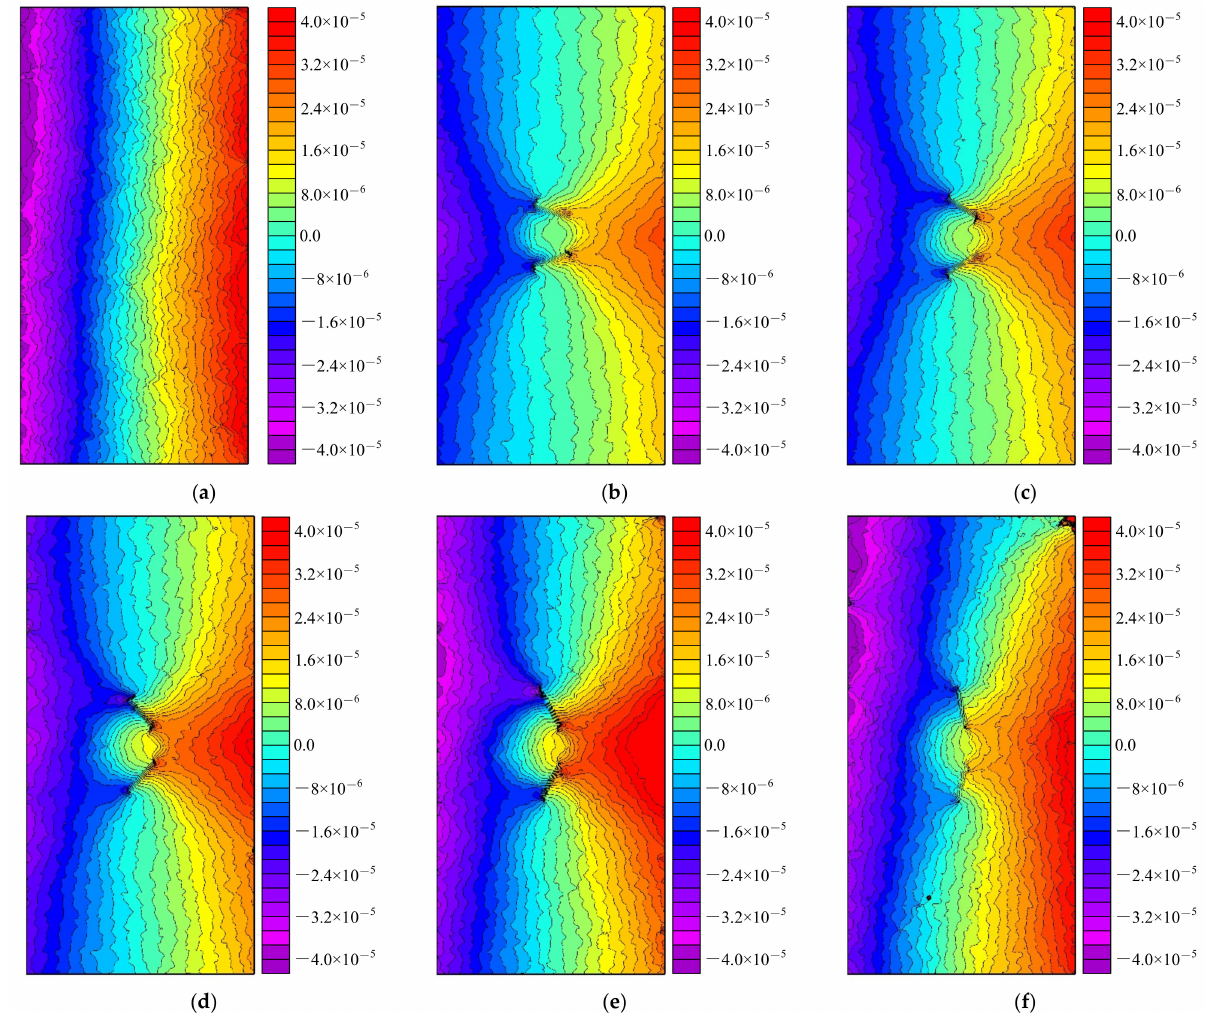
Figure 14. The lateral displacement field of different numerical models under crack initiation stress (Unit: m). ( a ) Intact model; ( b ) β = 15 ◦ ; ( c ) β = 30 ◦ ; ( d ) β = 45 ◦ ; ( e ) β = 60 ◦ ; ( f ) β = 75 ◦